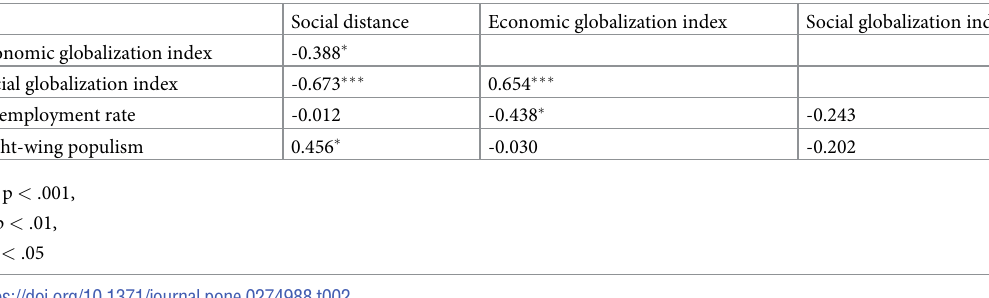
Table 2. Correlations among the dependent variable and country level variables (N =